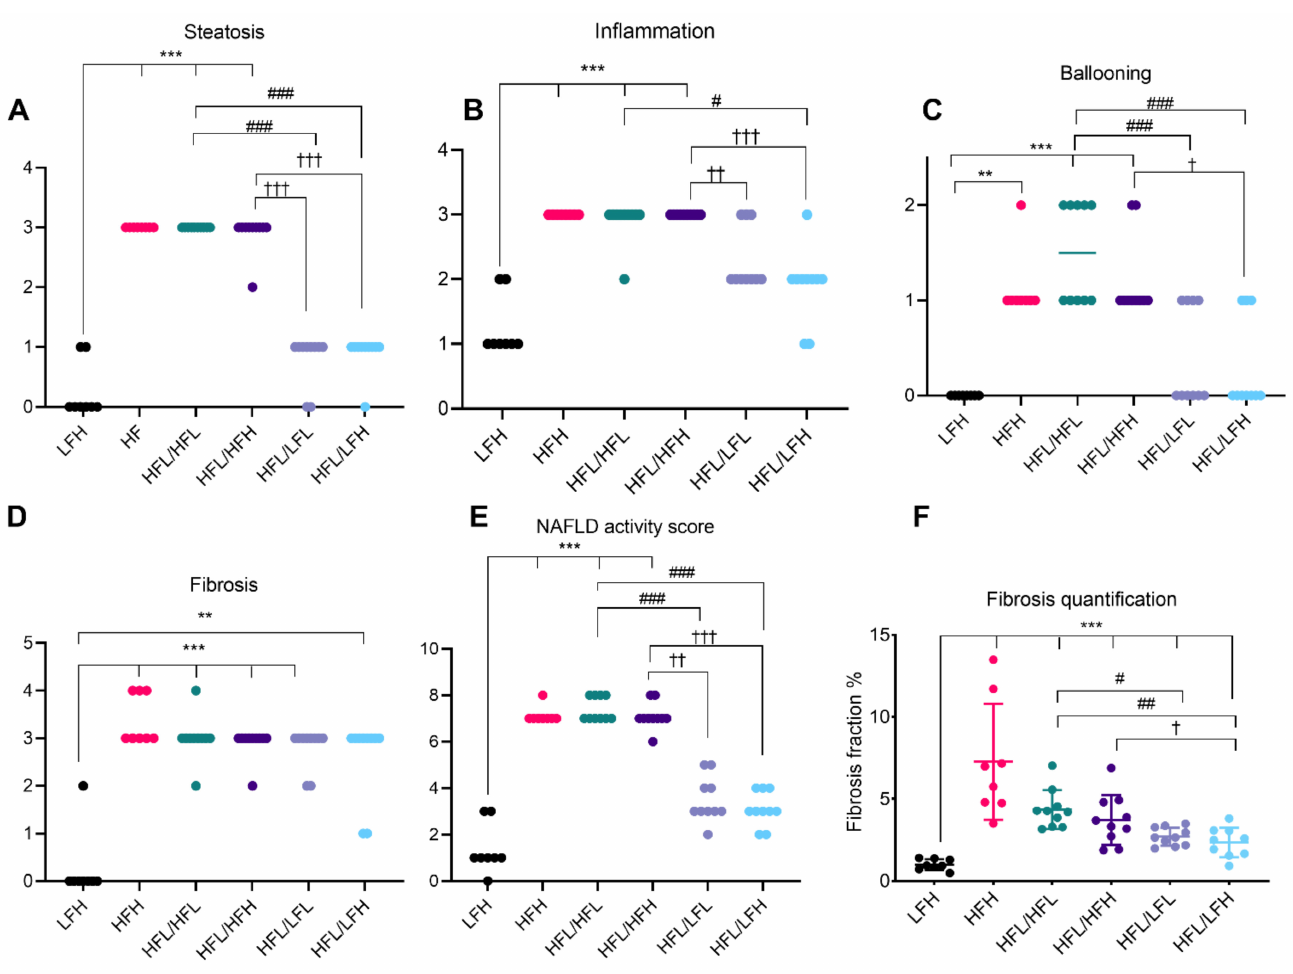
Figure 5. Hepatic histopathological scoring and fibrosis quantification at week 32. Data are rep- resented as individual values (scores) with medians ( A – E ) or means ± SD (F) ( n = 8–10/group). Semi-quantitative scoring results are depicted in ( A ) steatosis, ( B ) inflammation, ( C ) ballooning, and ( D ) fibrosis. ( E ). Cumulative NAFLD activity score for each animal. ( F ). Fibrosis fraction quantified by image analyses of picrosirius red stained sections and displayed as % of total tissue (section) area. Scoring was analyzed by a non-parametric Kruskal–Wallis with a Dunn’s multiple comparisons test, comparing all groups to LFH or to post-intervention groups in a separate analysis. For fibrosis quantification, LFH vs. all groups was analyzed by one-way ANOVA with Dunnett’s multiple comparisons test on log transformed data and, for intervention groups, data were analyzed by a two-way ANOVA with a Tukey’s test for multiple comparisons. Difference from LFH. ** p < 0.01, *** p < 0.001. Difference from HFL/HFL: # p < 0.05; ## p < 0.01; ### p < 0.001. Difference from HFL/HFH: † p < 0.05; †† p < 0.01; ††† p < 0.001. HFH: high fat high vitC, HFL: high fat low vitC, LFL: low fat low vitC, LFH: low fat high vitC, VitC: vitamin